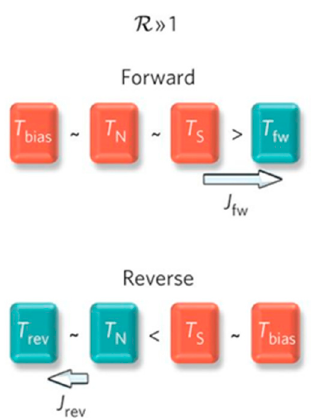
Figure 13. Representation of the diode’s performance in two different configurations. Reprinted with permission from Springer Nature Publishing Group.